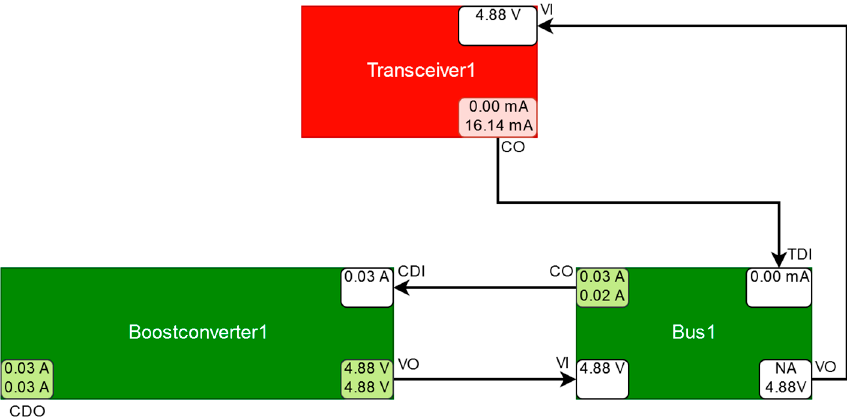
Figure 23. Simplified schematic depiction of the suspected component Transceiver1 and its relevant surrounding components (explanation see Figure 20).